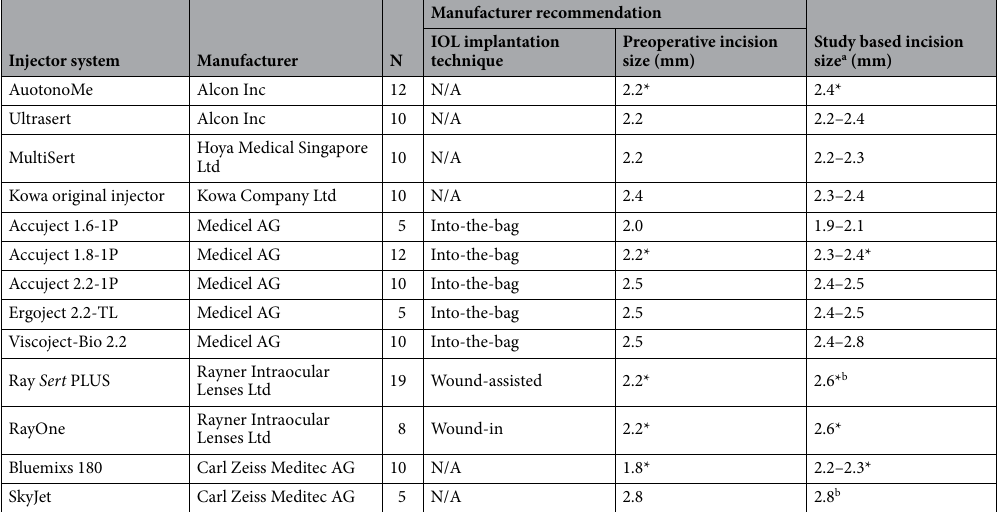
Table 1. Preoperative incision size recommendations of intraocular lens injector systems. IOL intraocular lens. a Using an Into-the-bag IOL implantation technique. b Possibly undersized due to reaching the scale limit of 3.0 mm. *Discrepancy between the manufacturers’ preoperative incision size recommendation and the study-based preoperative incision